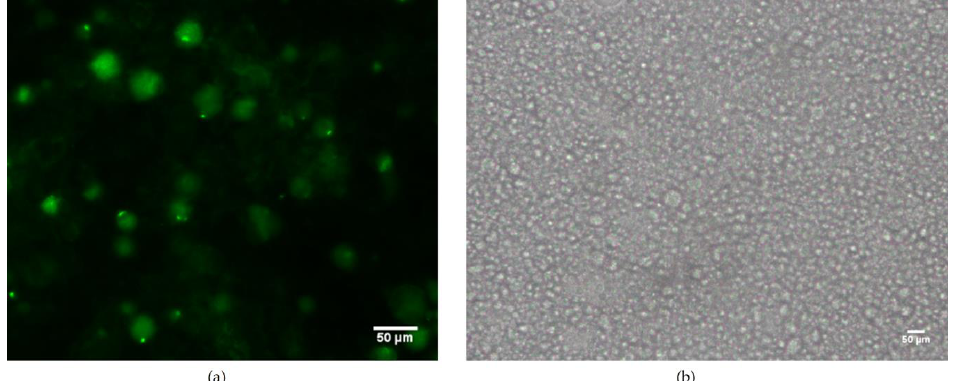
Figure 4. The inside structure of AAN-16 E ( a ) and emulsions’ placebo ( b ) using a fluorescence microscope.